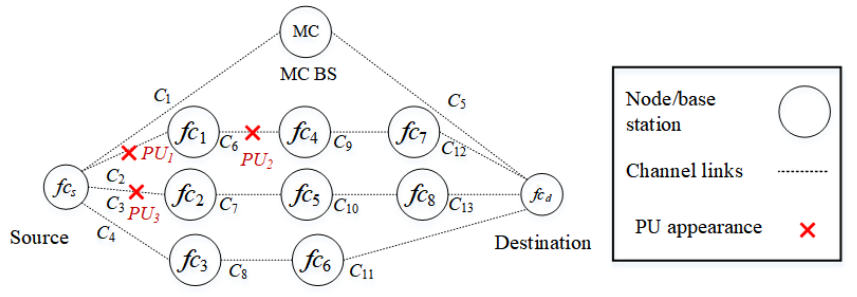
Figure 7. Scenario 2: The appearance of PUs in routes k 3 and k 4 interfere with channels c 2 , c 3 , and c 6 .